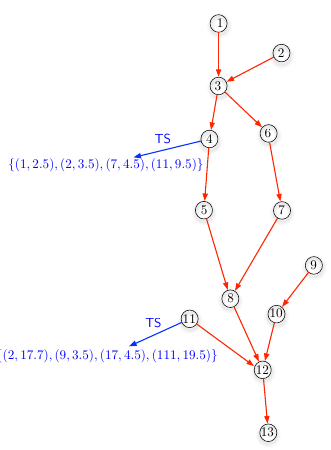
Figure 2. An example of a sensor network with the time series attached to the sensor nodes 4 and 11 indicated in blue. Again, we note that the nodes represent the segments of a